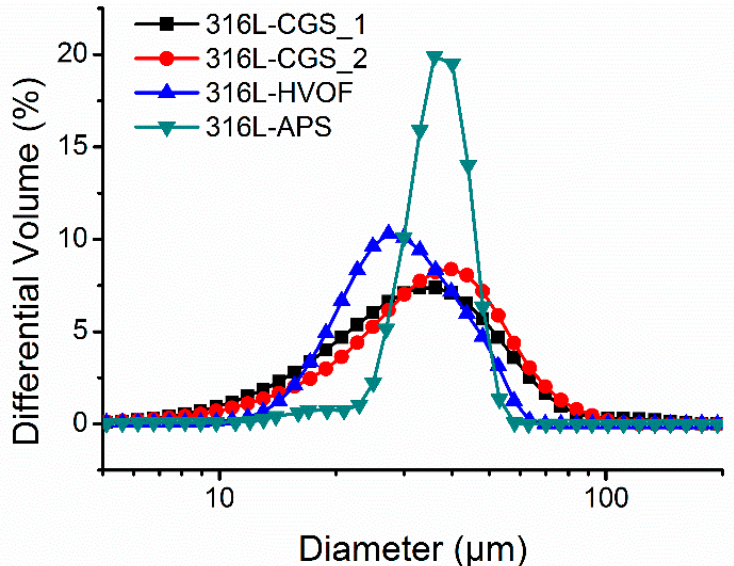
Figure 4. Particle distribution of the 316L feedstock powders.